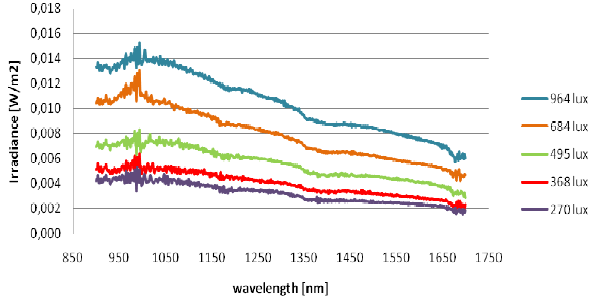
Figure 3. Changes in irradiance within the 900-1700nm range taken at 5 different scene